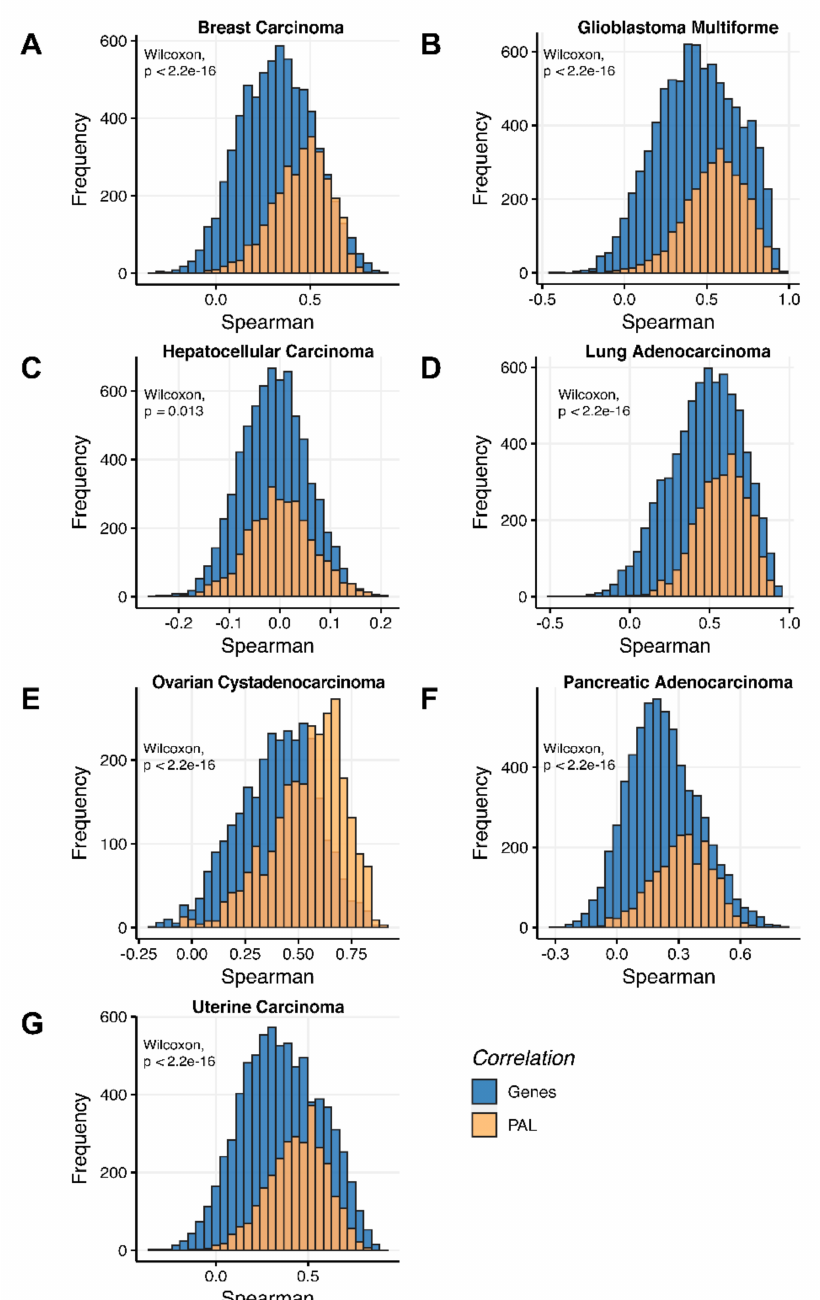
Figure 12. Gene-to-gene and PAL-to-PAL Spearman correlation between RNA and protein expres- sion levels estimated by given gene or molecular pathway across ( A ) Breast Invasive Carcinoma, ( B ) Glioblastoma Multiforme, ( C ) Hepatocellular Carcinoma, ( D ) Lung Adenocarcinoma, ( E ) Ovar- ian Serous Cystadenocarcinoma, ( F ) Pancreatic Ductal Adenocarcinoma and ( G ) Uterine Corpus Endometrial